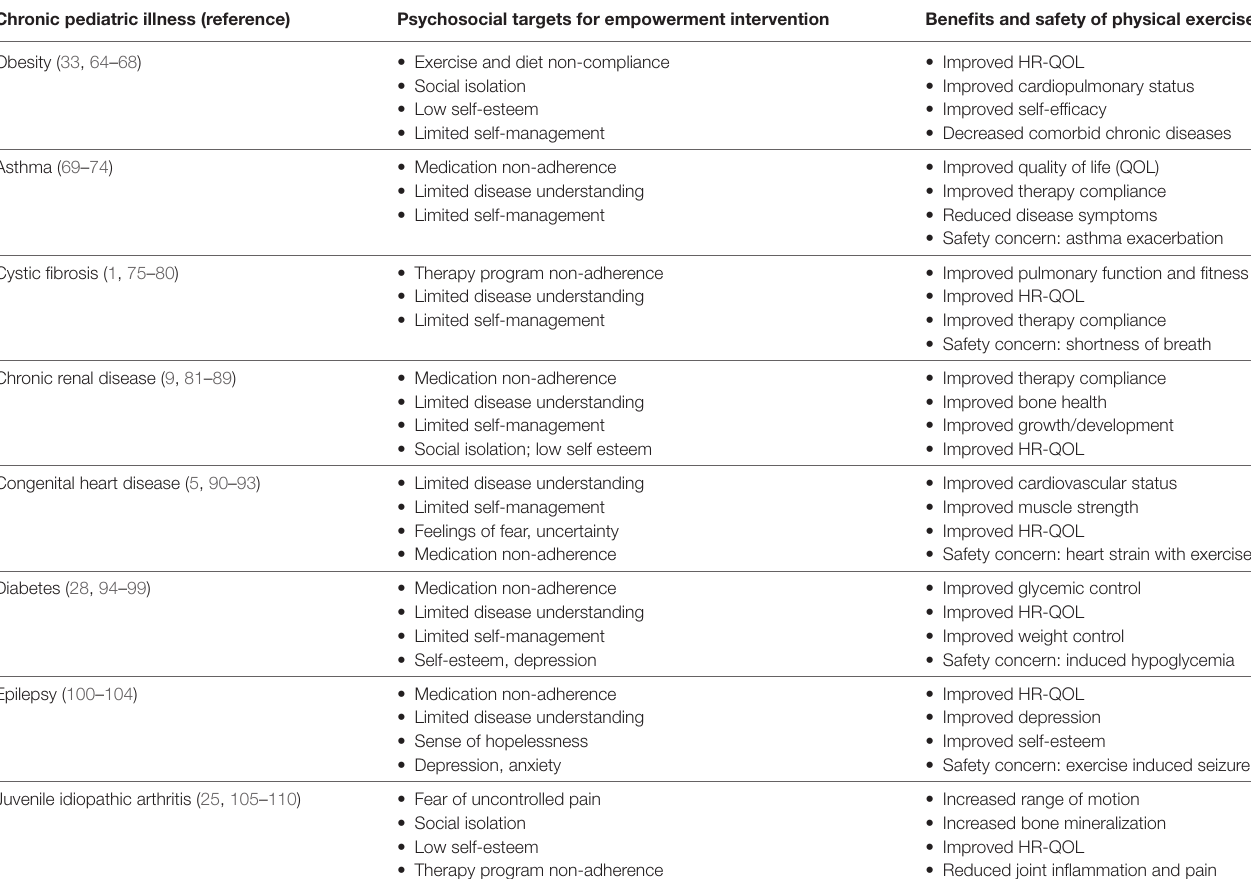
TaBle 2 | Diverse pediatric chronic diseases share similar psychosocial targets for empowerment intervention, and potential exercise benefits that could be addressed with disease-specific exercise–empowerment interventions like the prototype Empower Stars! video game. chronic pediatric illness (reference)